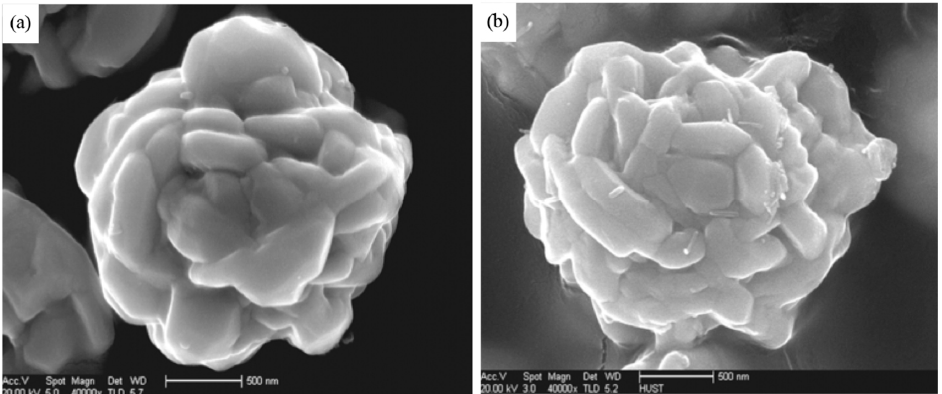
Figure 1. Typical scanning electron microscope (SEM) images of pseudo-spherical elemental silver nanoparticles (Ag-NP) at high resolution ( a ) none modifier; ( b ) at the presence of 1.0 g/L N-methyl 2-pyrrolidone [24].